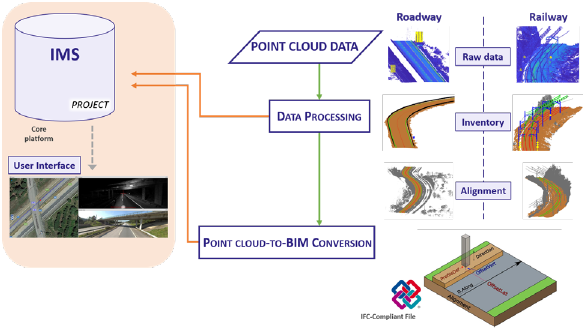
Figure 1. Workflow of the proposed